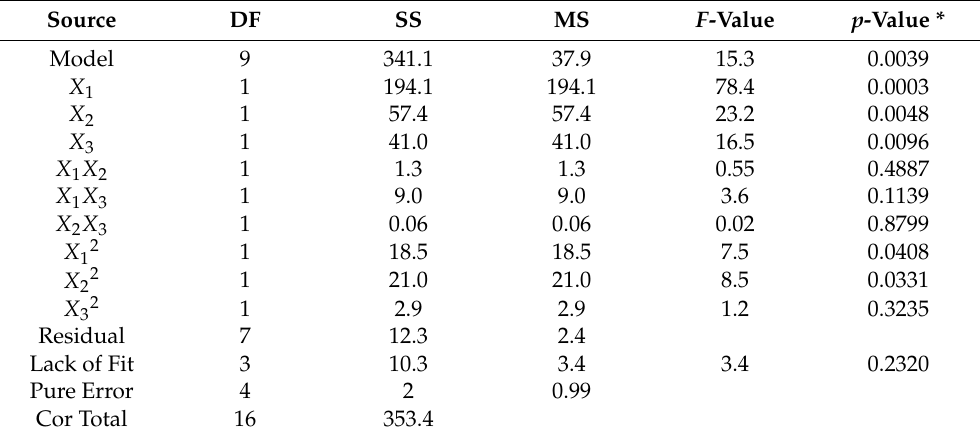
Table 2. Analysis of variance (ANOVA) of the fitted quadratic polynomial model for tetramethrin